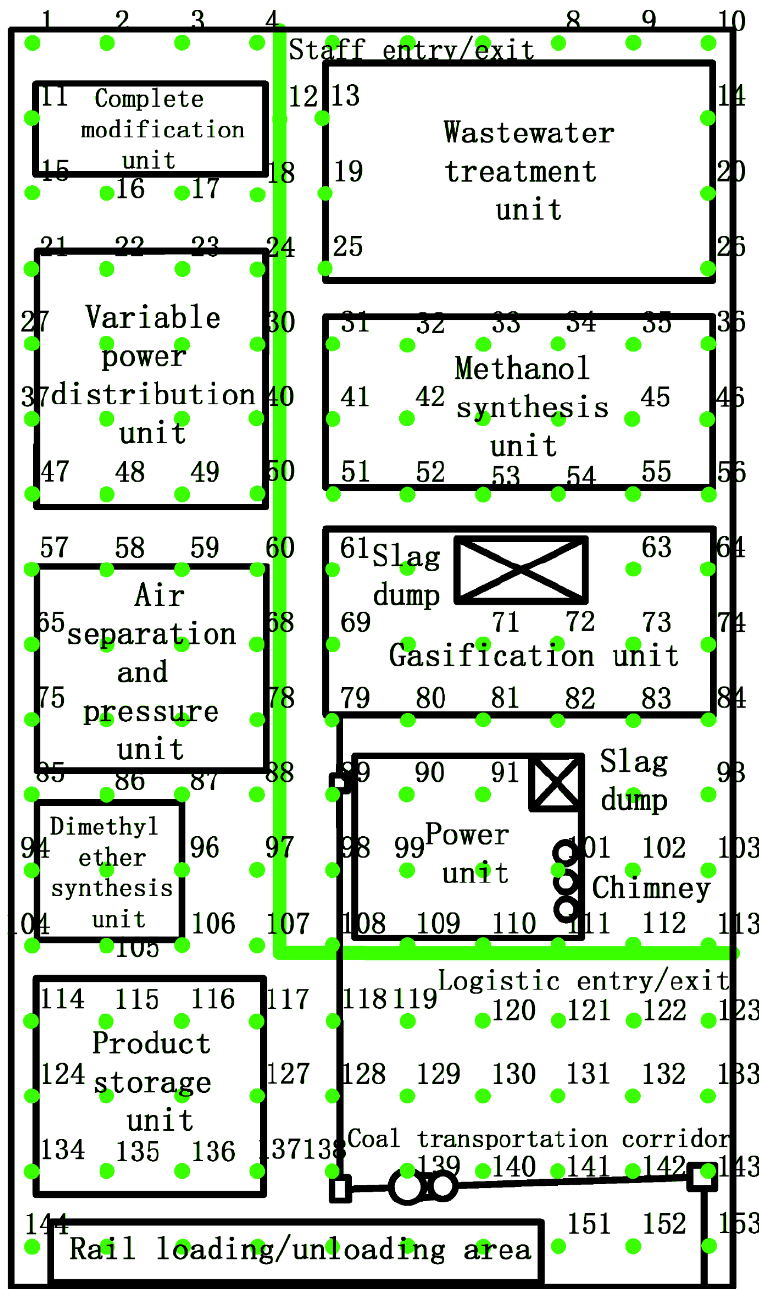
Figure 2. Distribution of the sampling points in the coal plant.